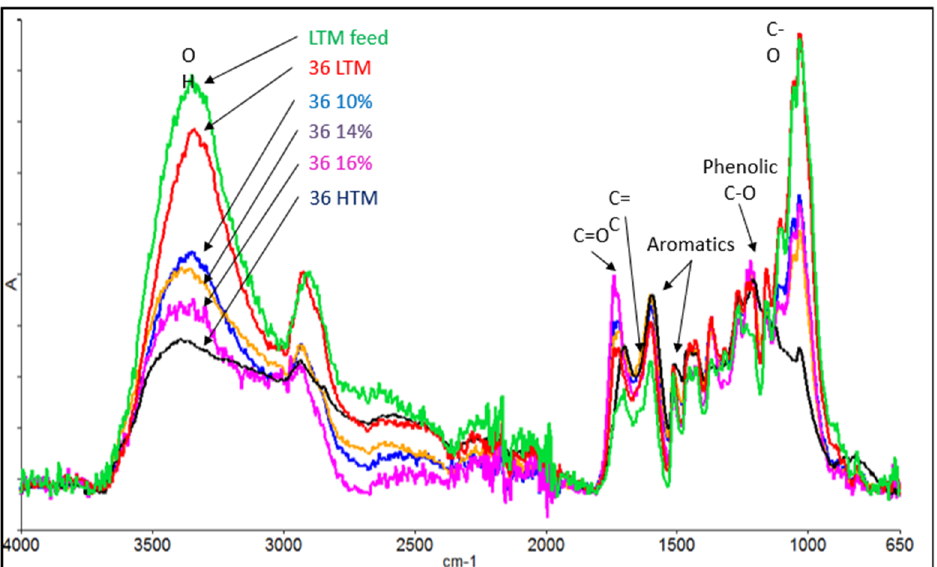
Figure 16. FTIR spectrums of the densified biomass samples.